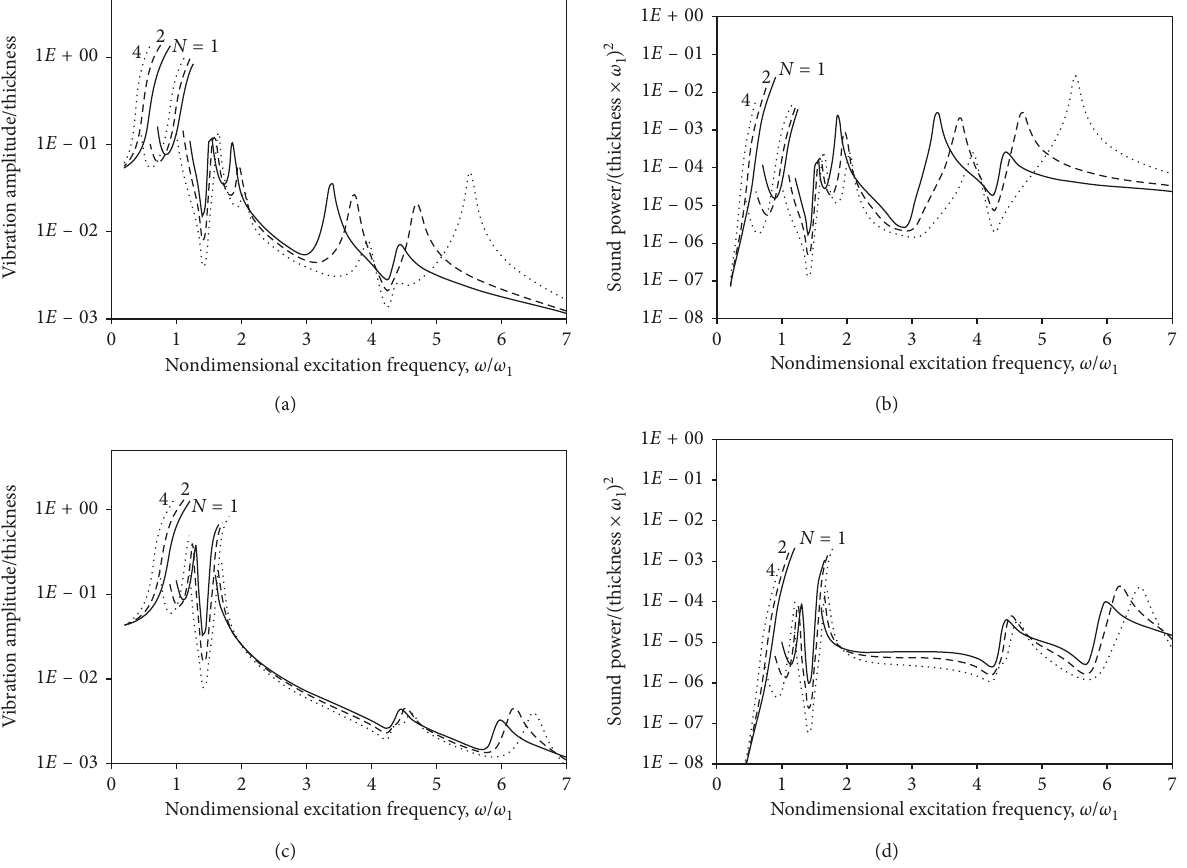
Figure 6: (a) Symmetric and (c) antisymmetric vibration amplitude versus excitation frequency for various numbers of flexible panels ( κ 0.2, a 3m, b c 0.5 m, and ξ 0.02); (b) symmetric and (d) antisymmetric sound radiation versus excitation frequency for various (cid:31) (cid:31) (cid:31) (cid:31) (cid:31) numbers of flexible panels ( κ 0.2, a 3 m, b c 0.5m, and ξ (cid:31) (cid:31) (cid:31) (cid:31) (cid:31)